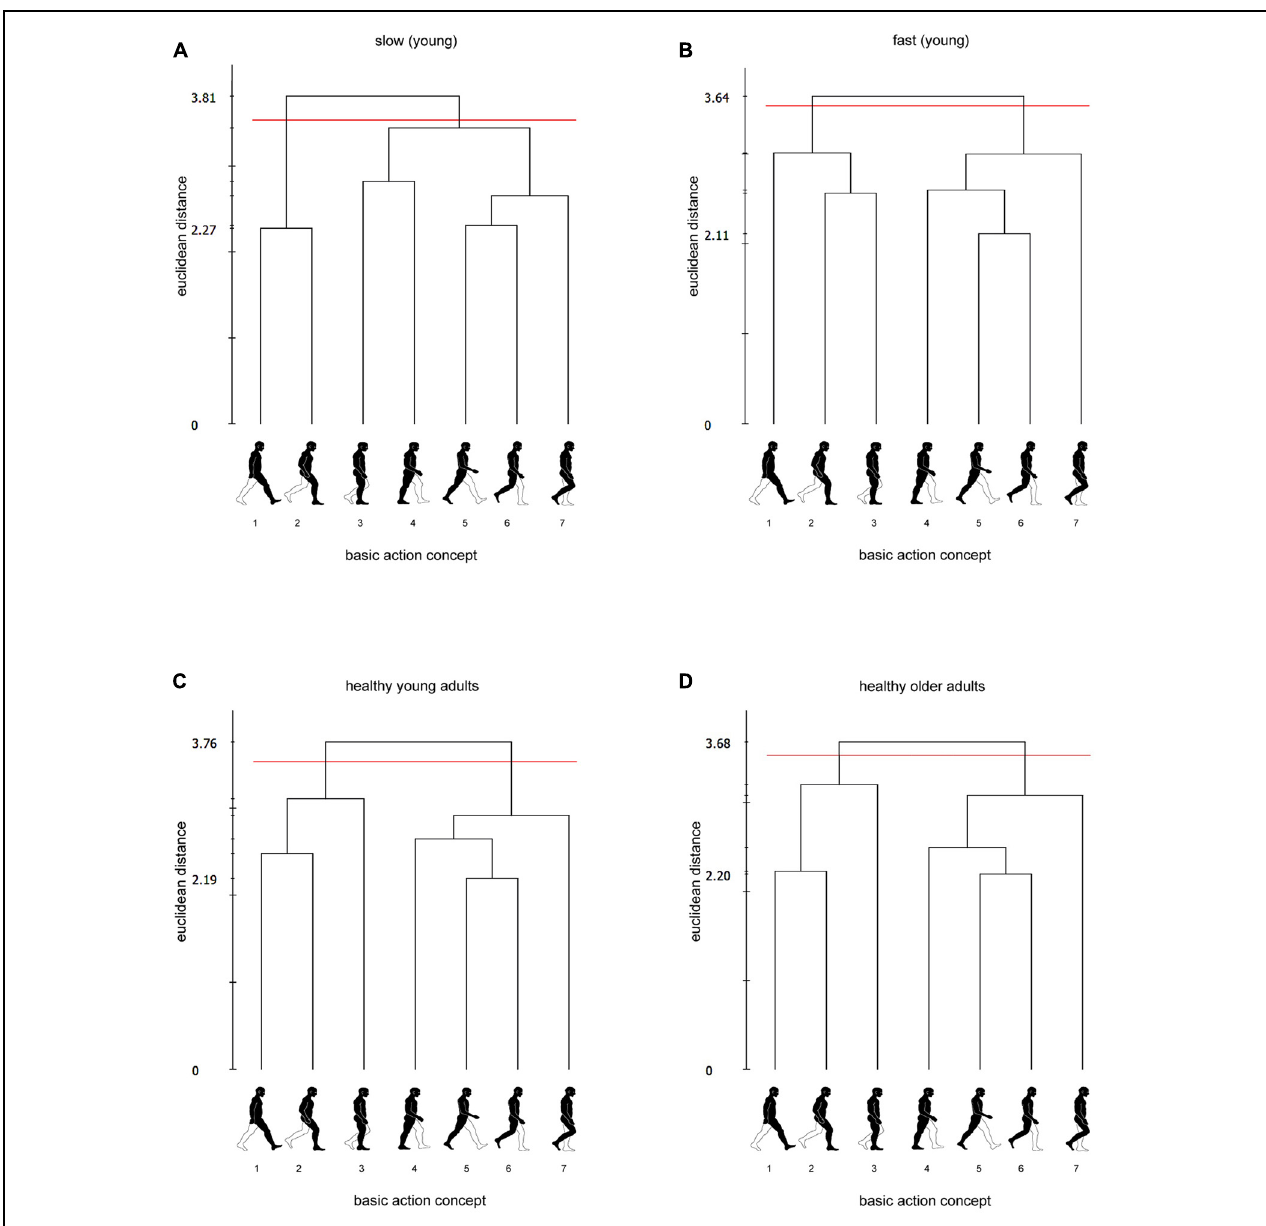
FIGURE 3 | Mean group dendograms for (A) slow-walking adults, (B) fast-walking adults, (C) healthy young adults and (D) healthy older adults. The y-axis displays the euclidean distance. The horizontal line marks